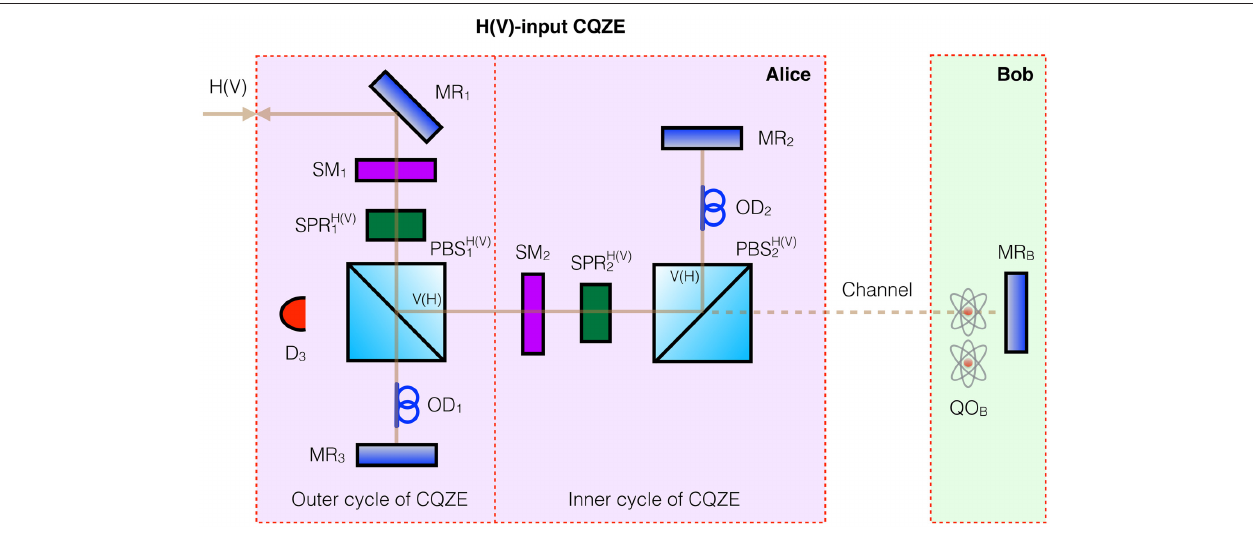
FIGURE 2 | Proposal for fully counterfactual CNOT gate based on Michelson CQZE. By using polarizing beamsplitter PBS H ( V ) that passes H ( V ) photons and reflects V ( H ) , this setup can take H ( V ) input from Alice, i.e., “0”(“1”), but not yet a superposition. Bob implements his qubit as a superposition of blocking and not blocking the channel using his quantum object QO B . Switchable mirror SM 1(2) is initially turned off allowing the photon in, but is then turned on for M ( N ) outer(inner) cycles before it is turned off again, allowing the photon out. The combined action of switchable polarization rotators SPR and polarizing beamsplitters PBS achieves the function of beamsplitters BS in the Mach-Zehnder version of Figure 1 . MR stands for mirror, and OD for optical delay. Again, complete counterfactuality is ensured as any photon going into the channel would either be lost due to measurement by Bob’s object QO B or else end up at detector D 3 : the chained quantum Zeno effect. For large enough M and N , the probability amplitude of the photon being in the channel is virtually